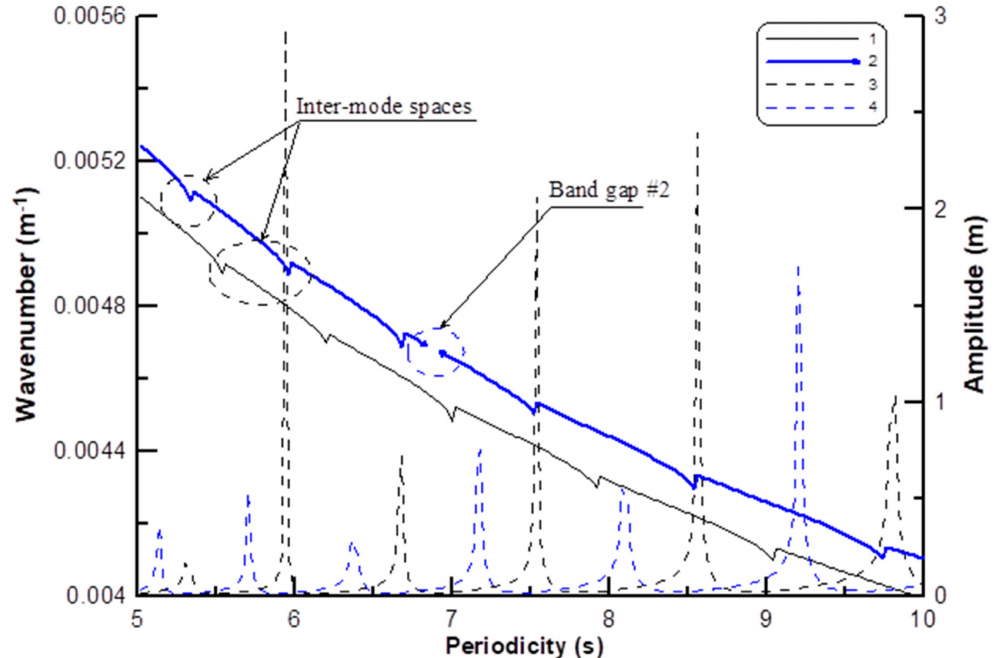
Figure 2. The dispersion spectra (curves 1–2) and the amplitude spectra (curves 3–4). The ice-shelf length is 16 km, the width is 0.8 km, and the thickness is 100 m. 1—the dispersion spectrum obtained for the intact ice shelf free of crevasses. 2—the dispersion spectra obtained for the crevasse-ridden ice shelf ( d cr = 20 m). Curves 3 and 4 are the amplitude spectra obtained, respectively, for the intact ice shelf free of crevasses and for the crevasse-ridden ice shelf ( d cr = 20 m). Spatial periodicity of the crevasses is equal to 1 km. Young’s modulus = 9 GPa, Poisson’s ratio ν = 0.33 [53].